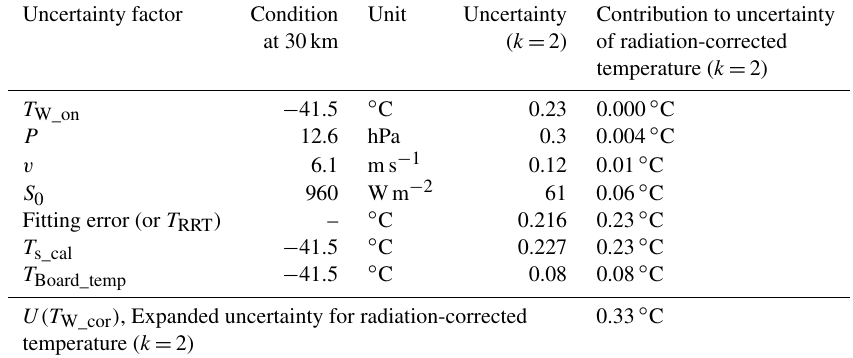
U(T W_cor ) , Expanded uncertainty for radiation-corrected temperature ( k = 2)